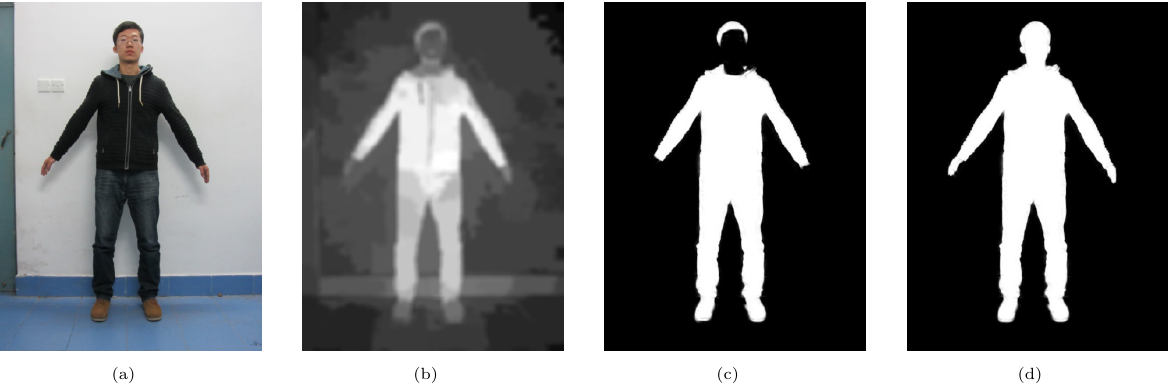
Fig. 3 Mask generation. We first extract a saliency heatmap (b) from the input (a); this heatmap lacks some body parts (c). A skin detector is used to overcome this problem, and the final mask (d) is optimized by median filtering and guided image